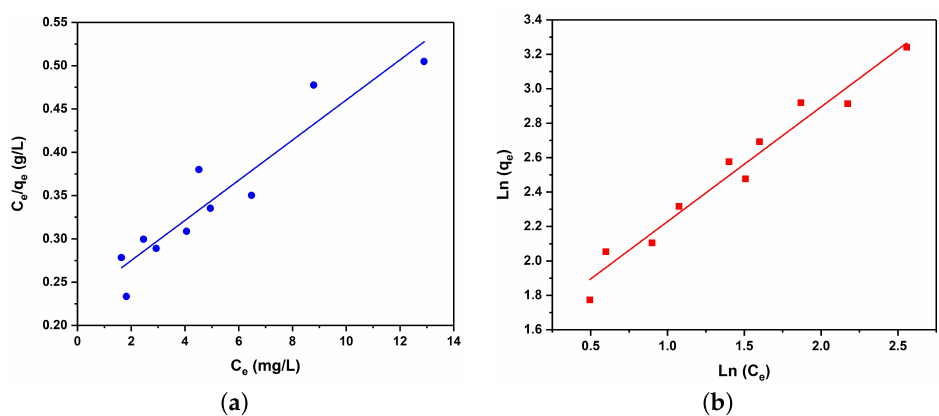
Figure 2. Adsorption isotherms fitted by linearized form of ( a ) Langmuir and ( b ) Freundlich model for adsorbed Pb 2 + by SO 3 H-UiO-66(Zr).